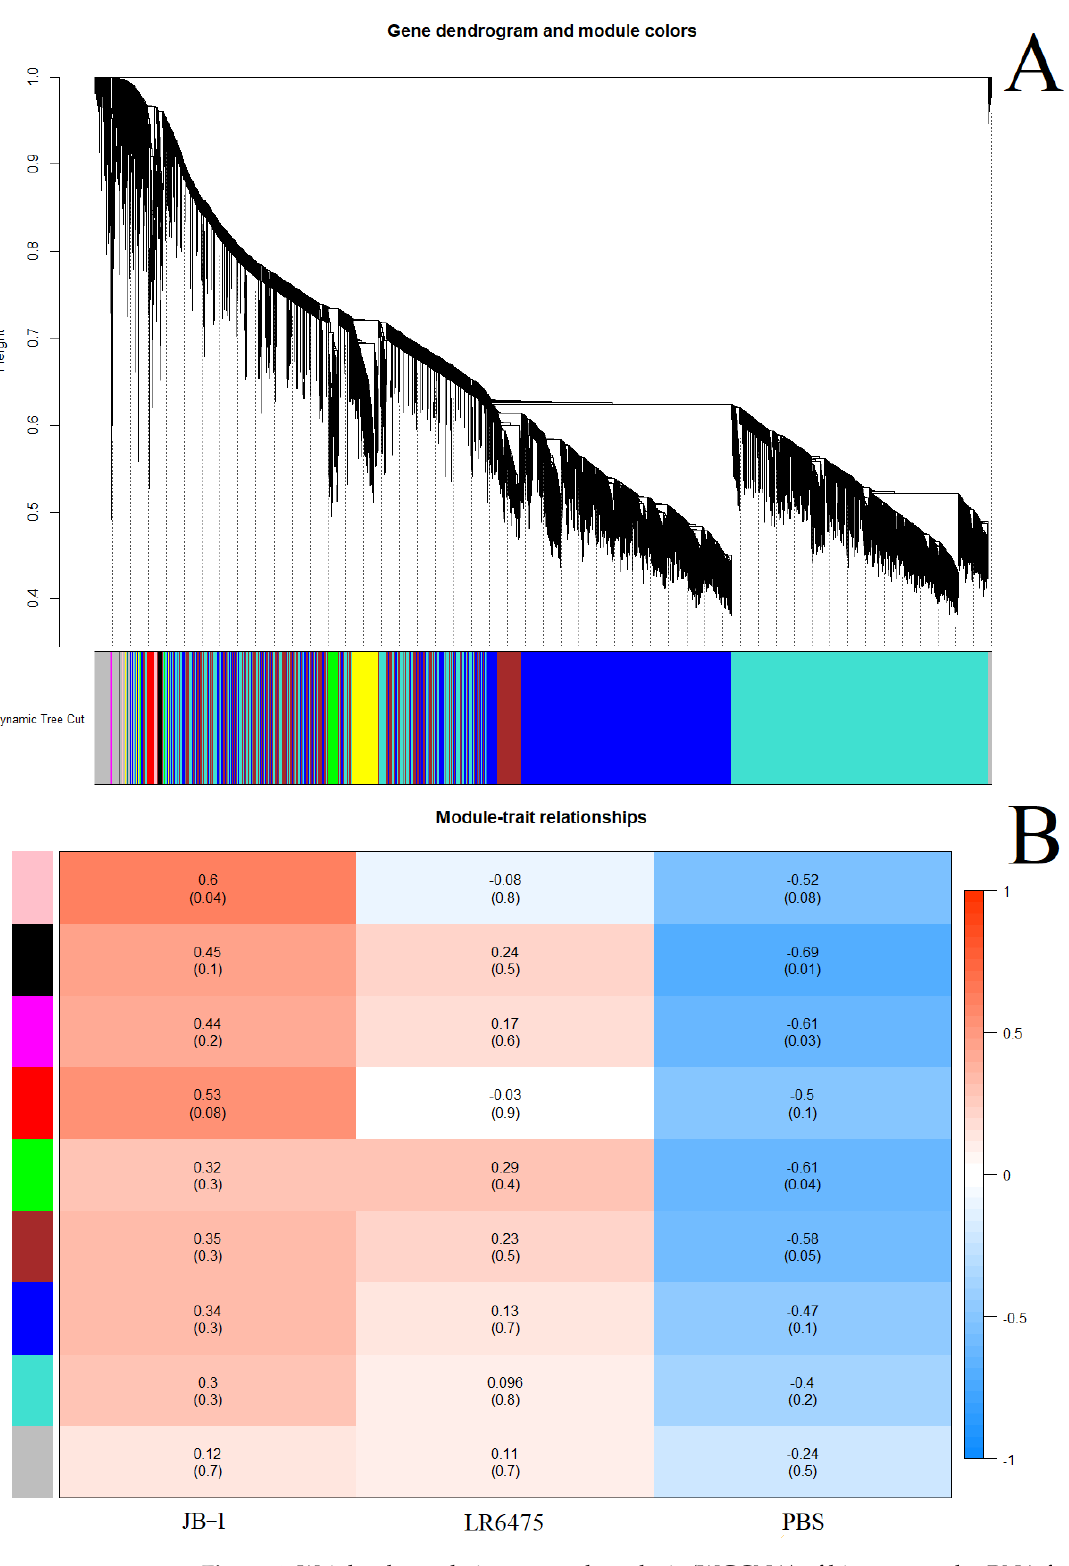
Figure 4. Weighted correlation network analysis (WGCNA) of hippocampal mRNA from mice fed one of JB-1, LR6475, or PBS. ( A ) Unsupervised cluster dendogram of commonly co-expressed genes shown grouped into modules by colour. ( B ) Gene module and feed group relationships shown in a heatmap with relative expression level and p -value in brackets under it for each